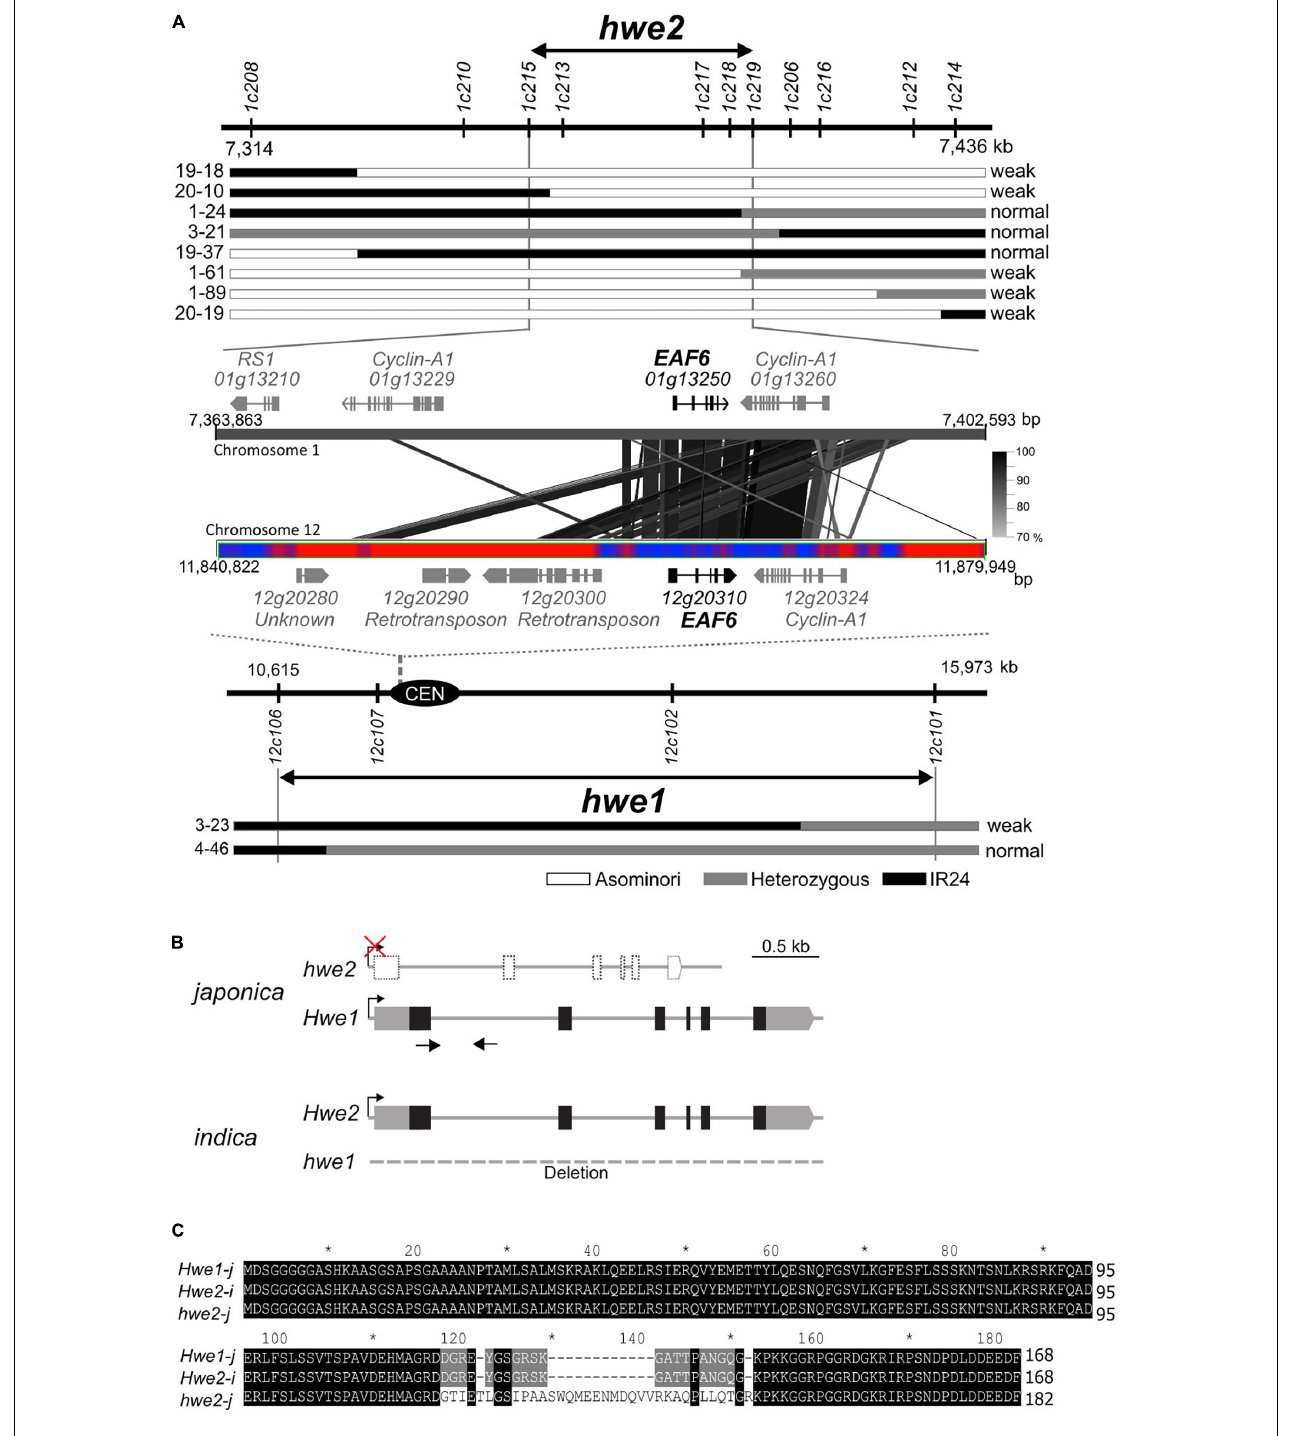
FIGURE 2 | Identification of causal genes for hwe1 and hwe2 . (A) Map locations of hwe2 ( upper ) and hwe1 ( lower ), and MSU7.0 gene annotation in candidate regions. The prefix “LOC_” in locus ID is omitted for convenience. The most informative recombinant genotypes are shown along with the maps. Similarity of DNA sequences between chromosomes 1 and 12 is shown as connected with black and gray lines. The bar with red and blue heat map represents the abundance of repetitive DNA sequences around the centromere (CEN) of chromosome 12. Red represents the repeat region. (B) Gene structure of HWE1 and HWE2 of japonica (Asominori) and indica (93-11). Gray and black boxes denote untranslated region (UTR) and coding sequence (CDS) of rice OsEAF6 , respectively. The CDS sequences of OsEAF6 were identical between japonica and indica . (C) Multiple alignments of predicted OsEAF6 protein sequences of japonica ( Hwe1-j and hwe2-j ) and indica ( Hwe2-i